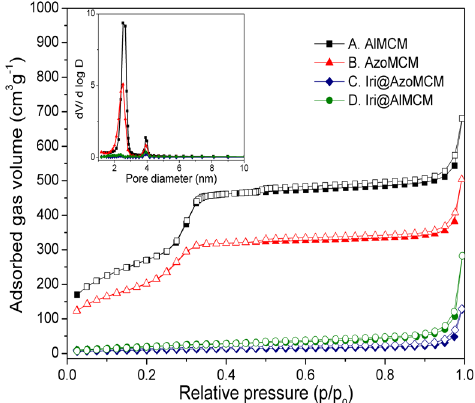
Figure 4. Nitrogen adsorption – desorption isotherms for A) AlMCM-41, B) AzoMCM, C) Iri@AzoMCM and D) Iri@ AlMCM. Inset, pore size distribution computed with BJH